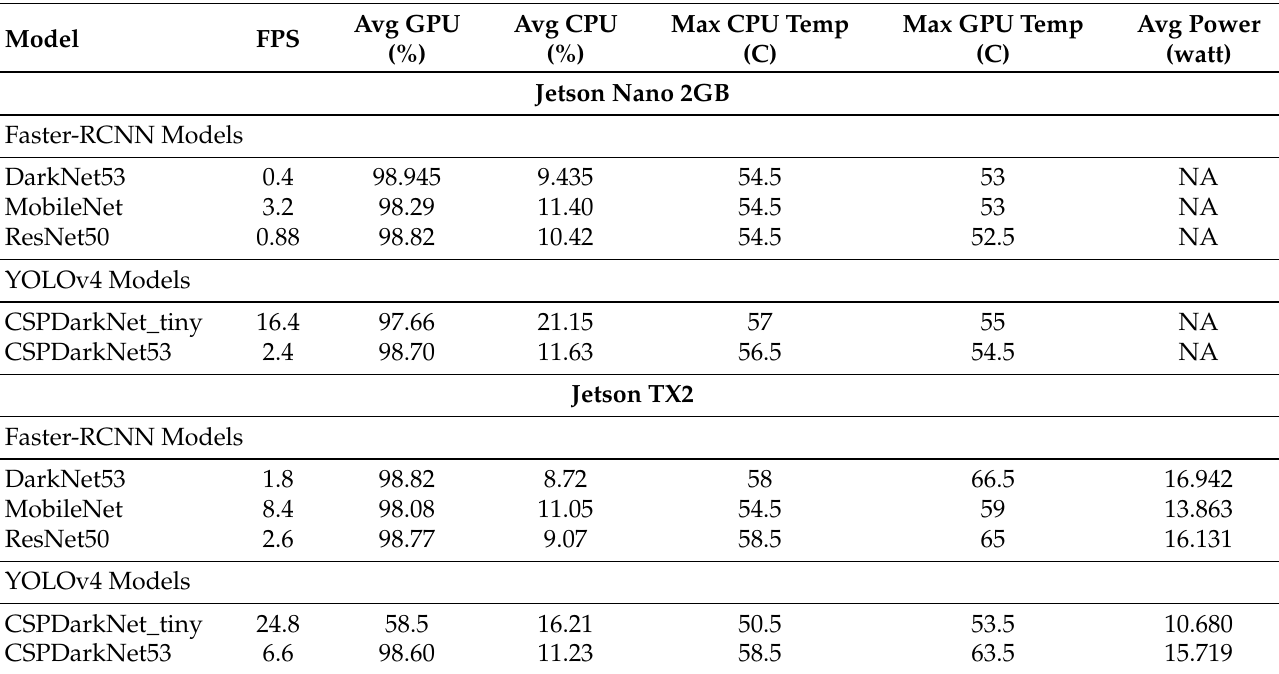
Table 6. Quantitative hardware performance of implemented computer vision models benchmarked on NVIDIA